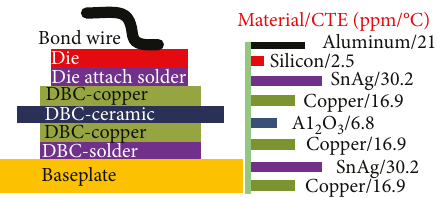
Figure 1: Physical framework of power module.